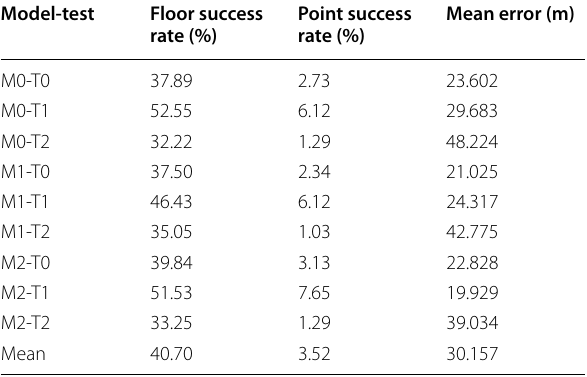
Table 8 The results of different classifiers and testing samples using DT Model-test